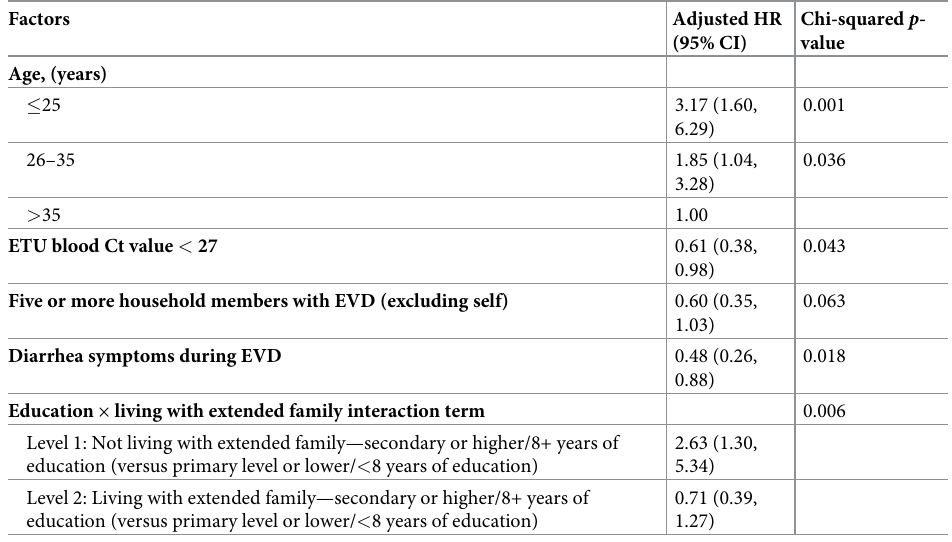
(compared to age � 25 years). Twenty percent remained positive at 1 year in this group (gener- alized log-rank p = 0.001) (Table 4; Fig 3). For those with milder acute disease (blood Ct value � 27), persistence was not significantly different between the 2 age groups (generalized Table 4. Multivariate model in a subset of 121 participants with available ETU blood Ct